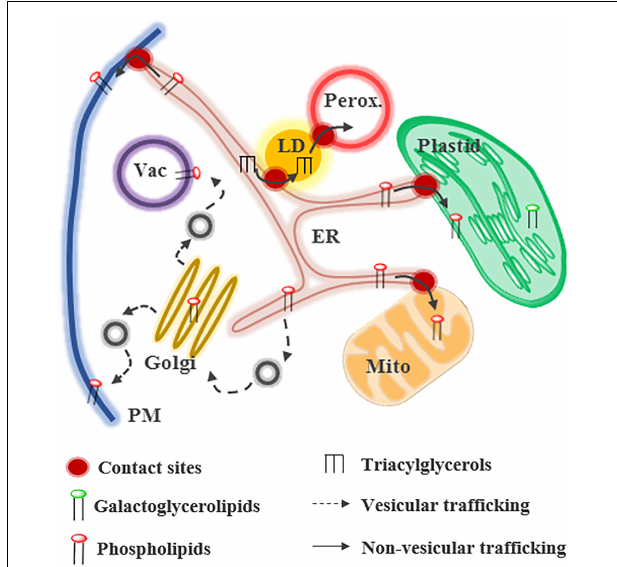
FIGURE 1 | Glycerolipid trafficking in plant cells. Lipids can be transferred by vesicular or non-vesicular routes at contact sites between membranes. Phospholipids and triacylglycerols are mainly synthesized in the endoplasmic reticulum (ER) whereas galactoglycerolipids are synthesized in plastids. In presence of phosphate (Pi), galactoglycerolipids are located primary in plastids and extra-plastidial membranes contain phospholipids. LD, lipid droplet; Mito, mitochondria; Perox,